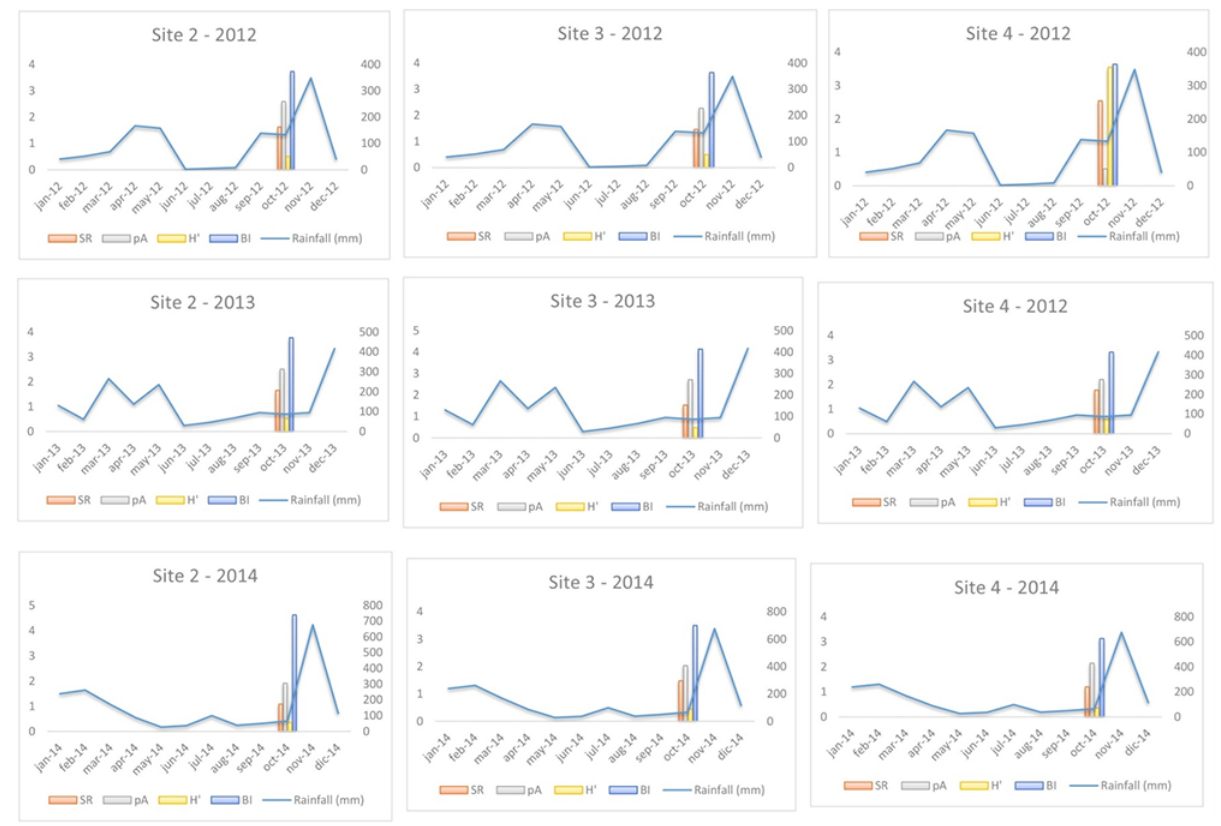
Figure 6 Graphical comparison of mean monthly rainfall detected during each surveyed year (2012–2014) in Sites 2, 3, and 4 with macrofungal biodiversity indices (on a logarithmic scale). SR – species richness; pA – population abundance; H ′ – Shannon Index; BI – Biomass Index. Rainfall is expressed in